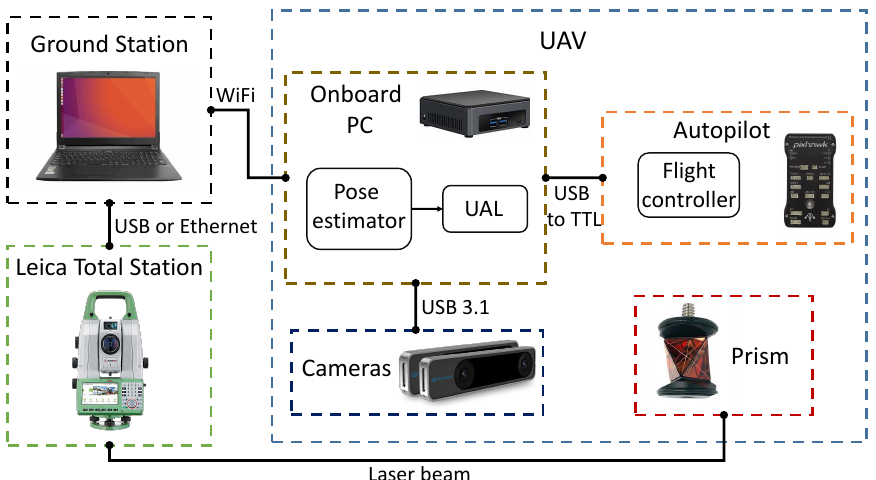
Figure 2. System architecture. The UAV localization is obtained by fusing observations from multiple onboard cameras and a total station on the